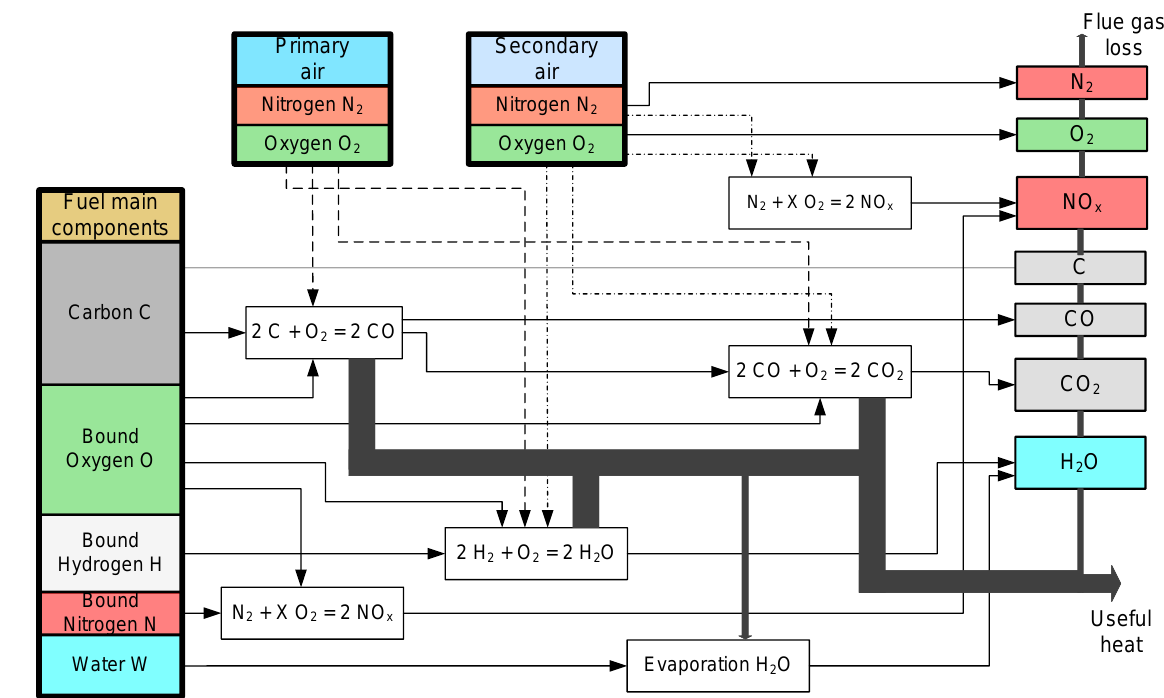
Figure 1. Basic chemical equations and biomass combustion products.